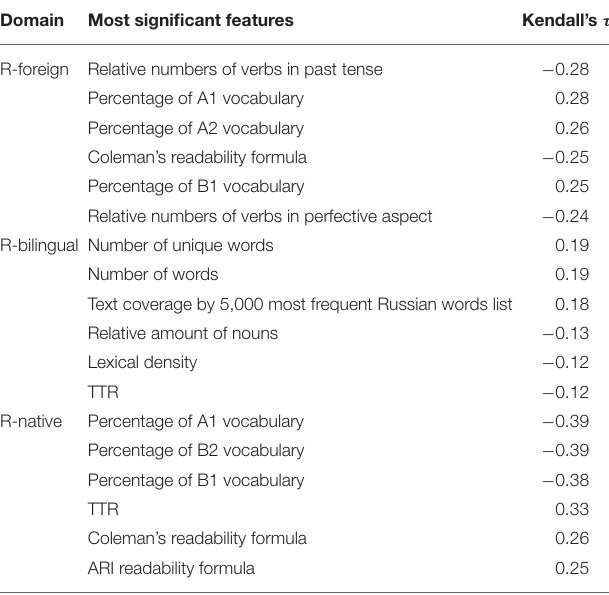
TABLE 3 | Selected Kendall’s tau correlations between the dependent variable (class) and various independent variables (features). Domain Most significant